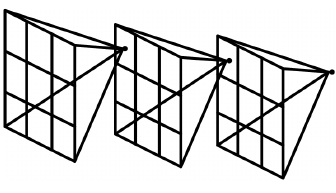
Figure 4. Receptive field plot.